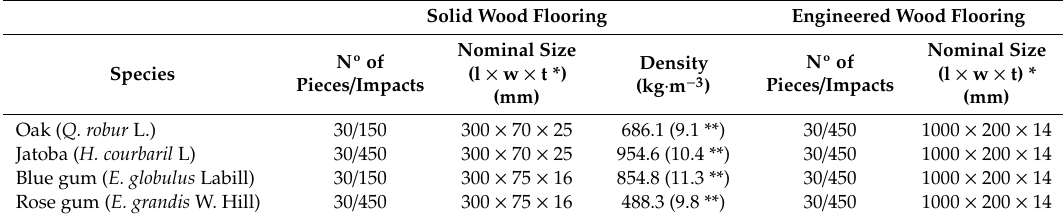
Table 1. Wood flooring types, species and properties.